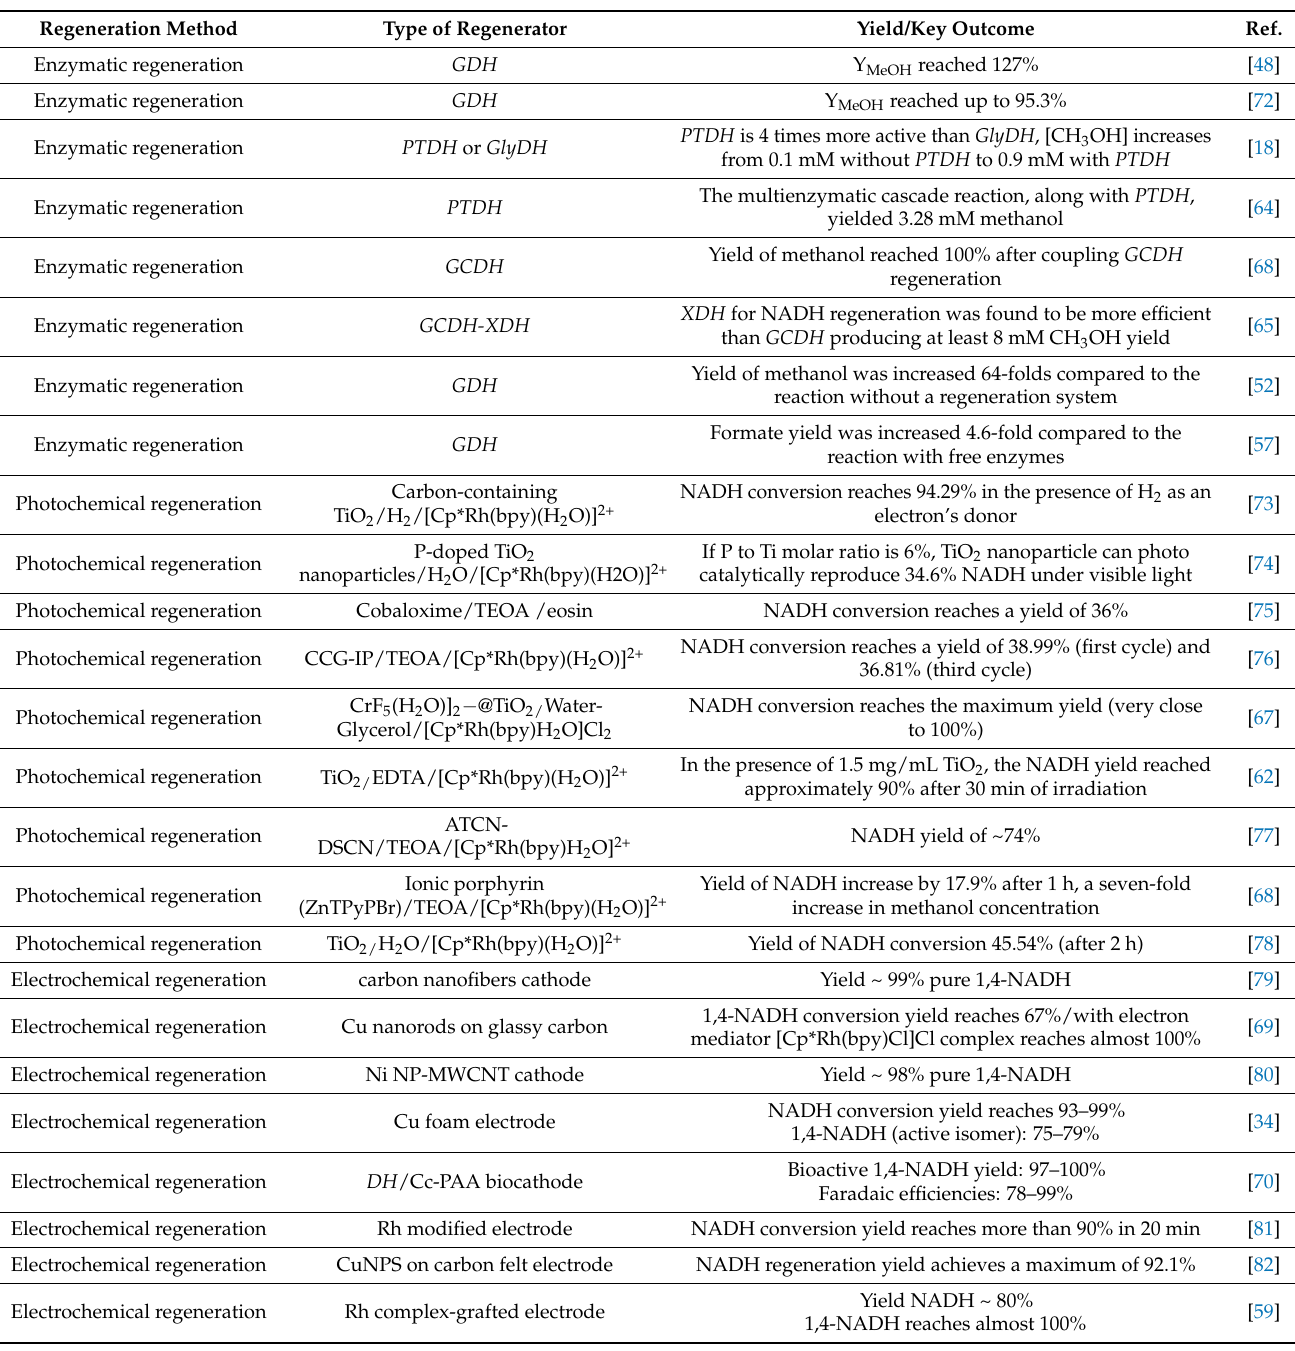
Table 5. Regeneration methods studied in the literature and their results